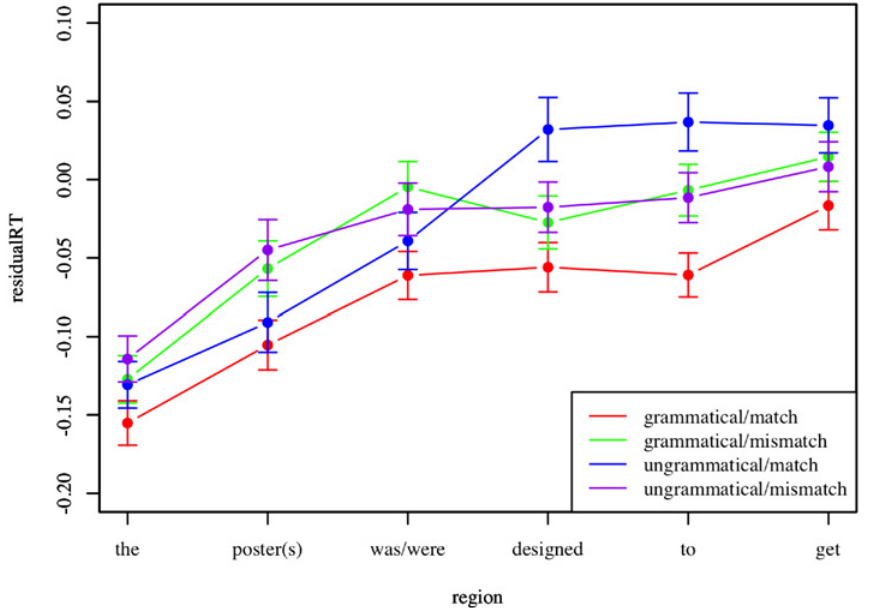
Fig 4. Agreement attraction with PP modifiers. Mean residual reading time is plotted by region for each condition in Experiment 2. Error bars represent standard error of the